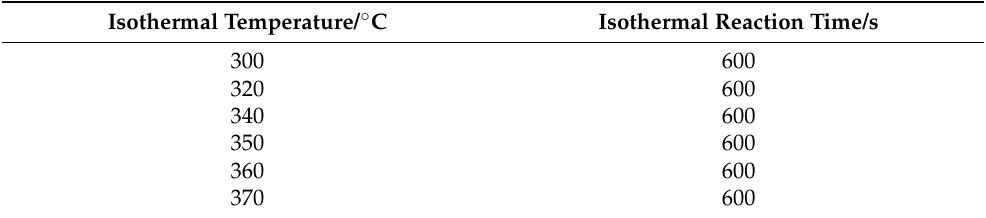
Table 2. Isothermal temperature values and corresponding isothermal holding times applied for characterizing high-temperature reaction kinetics of aromatically modified Polyamide